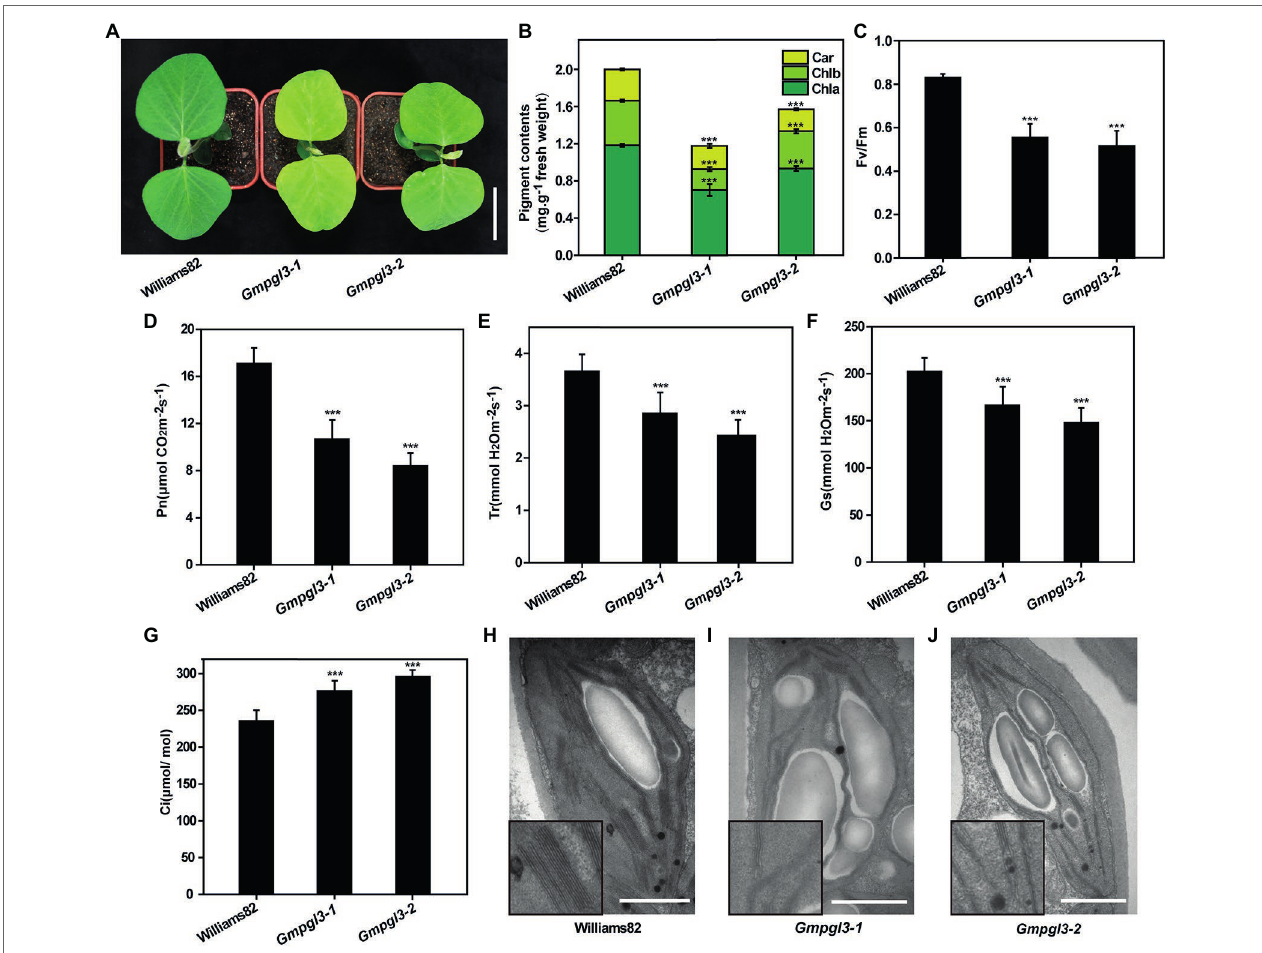
FIGURE 1 | (A) Phenotypes of the Williams 82, Gmpgl3-1, and Gmpgl3-2 mutants. Scale bars, 5 cm. (B–G) Pigment contents and photosynthesis parameters of the Williams 82, Gmpgl3-1, and Gmpgl3-2 mutants. (B) Chlorophyll a (Chl a), chlorophyll b (Chl b) and carotenoid (Car). (C) Chlorophyll fluorescence parameter (Fv/FM). (D) Photosynthetic rate (Pn). (E) Transpiration rate (Tr). (F) Stomatal conductance (Gs). (G) Intercellular CO 2 concentration (Ci). (H) Chloroplast structure in Williams 82. (I,J) Chloroplast structure in the Gmpgl3-1 and Gmpgl3-2 mutants. Scale bars, 1 μ m. *** represents significant differences compared with the control (Williams 82) at p < 0.001, and the error bars represent standard